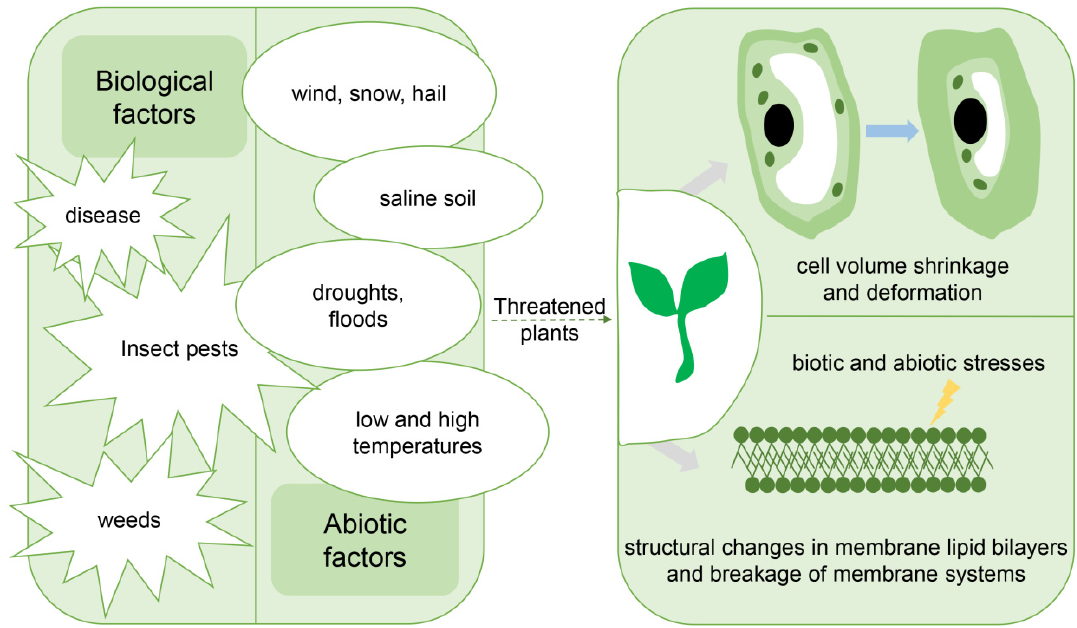
Figure 4. Some plant resistance factors and their effects. Plants are continuously exposed to biotic and abiotic stresses. Plant tolerance to biotic and abiotic stresses is controlled by cross tolerance. Although each stress will impose distinct physical and chemical effects on plants, most stresses will often directly or indirectly lead to water stress at the whole-plant scale, causing water loss, cell volume shrinkage and deformation, structural changes in the membrane lipid bilayer, and degradation of the membrane system. Therefore, a common basis for plant resistance is osmoregulation, changes in the interaction between membrane lipids and membrane proteins, and repair activities.